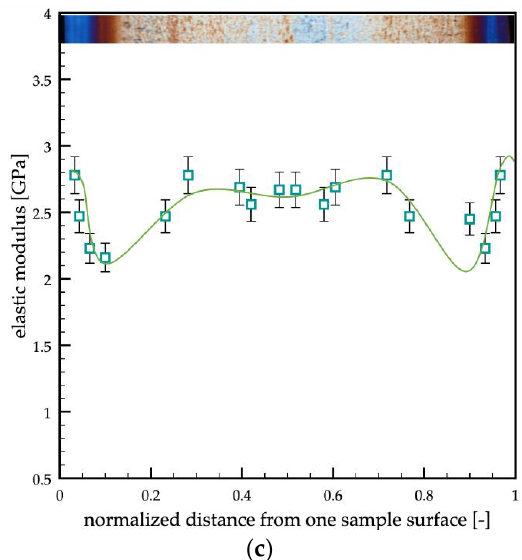
Figure 9. Elastic modulus distributions measured with the HarmoniX technique along the thickness of the ( a ) passive, ( b ) A, and ( c ) B sample.